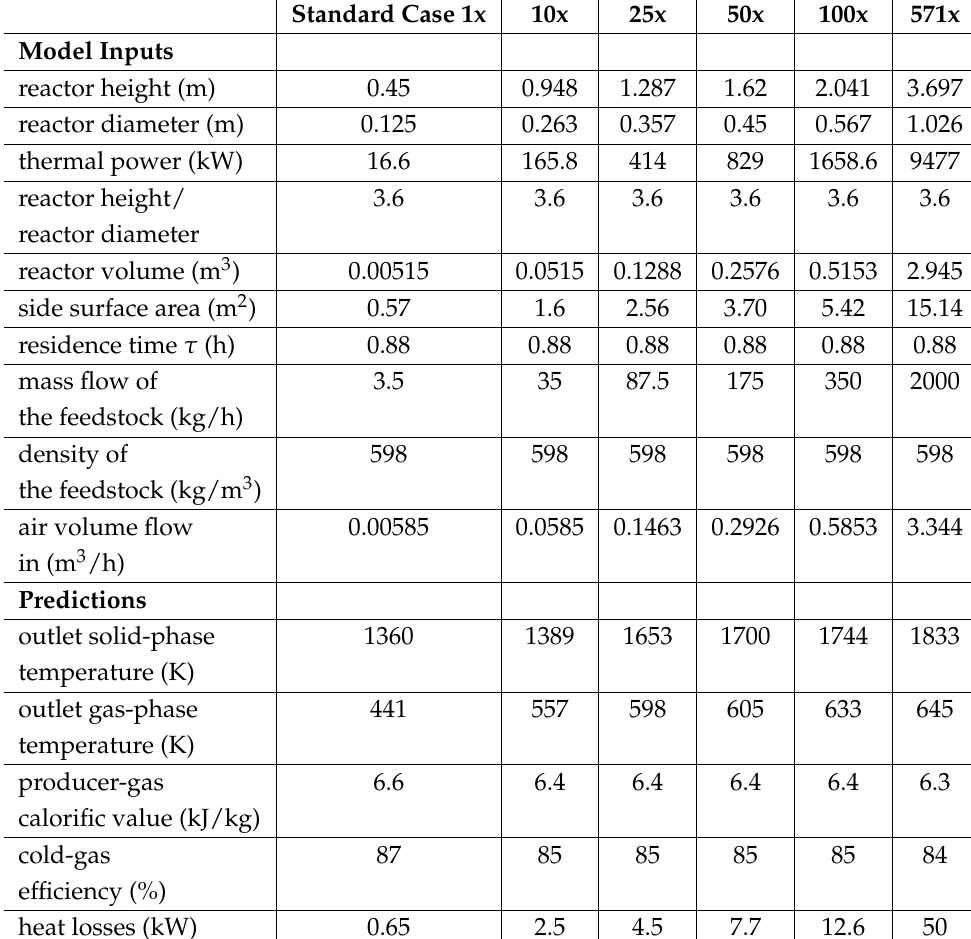
Table 8. Parameters of the reactor